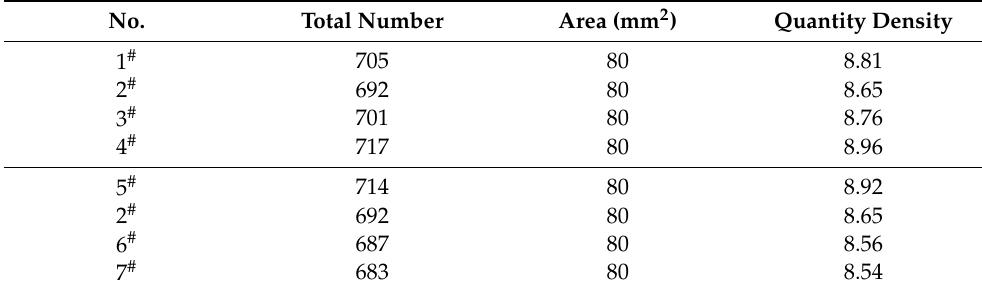
Table 4. Results of the inclusions in the 1 # ~7 # cast